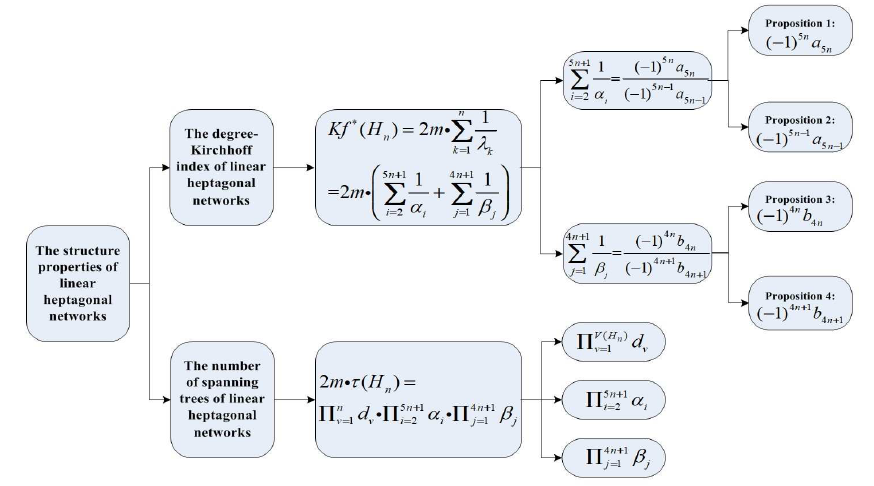
Figure 2. The steps processed in this